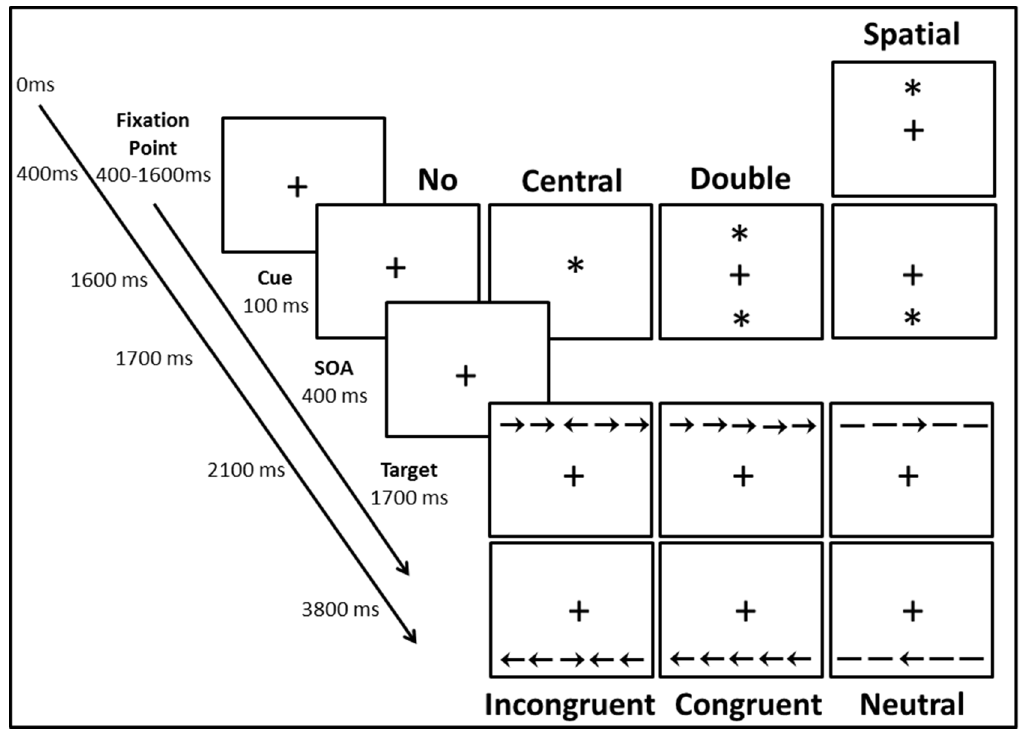
Figure 1. Attention Network Test (ANT). ANT design and procedure with the four warning cue conditions (no cue, central cue, double cue and spatial cue) and the three flanker conditions (Incongruent, Neutral and Congruent). The timing of events is presented on the left.